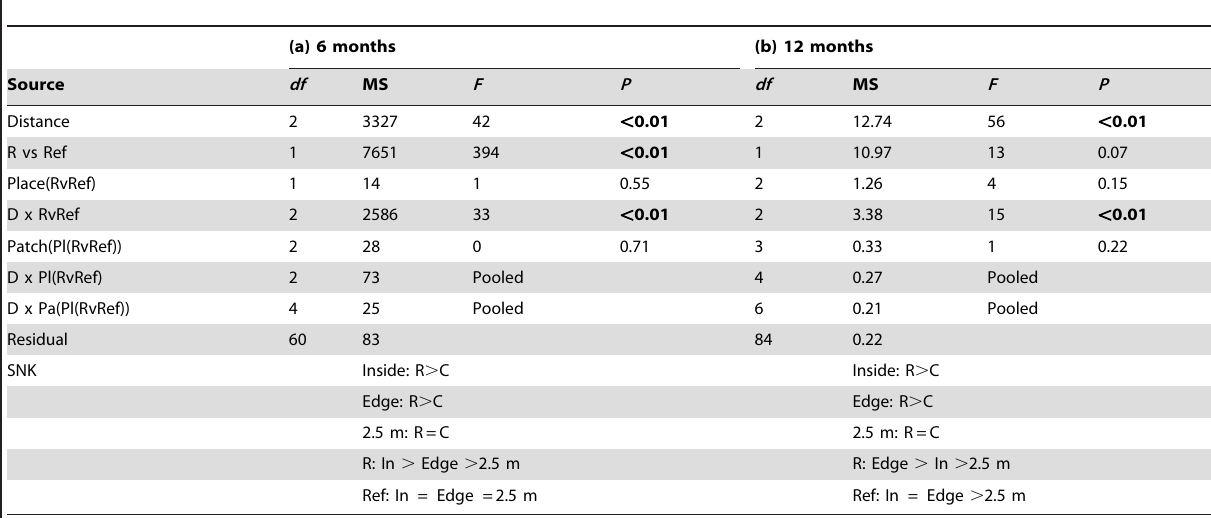
Table 3. Analyses of densities (0.1 m 2 ) of recruits at several distances from restored (R) or reference (Ref) patches of Phyllospora (a) six or (b) 12 months after the start of the second